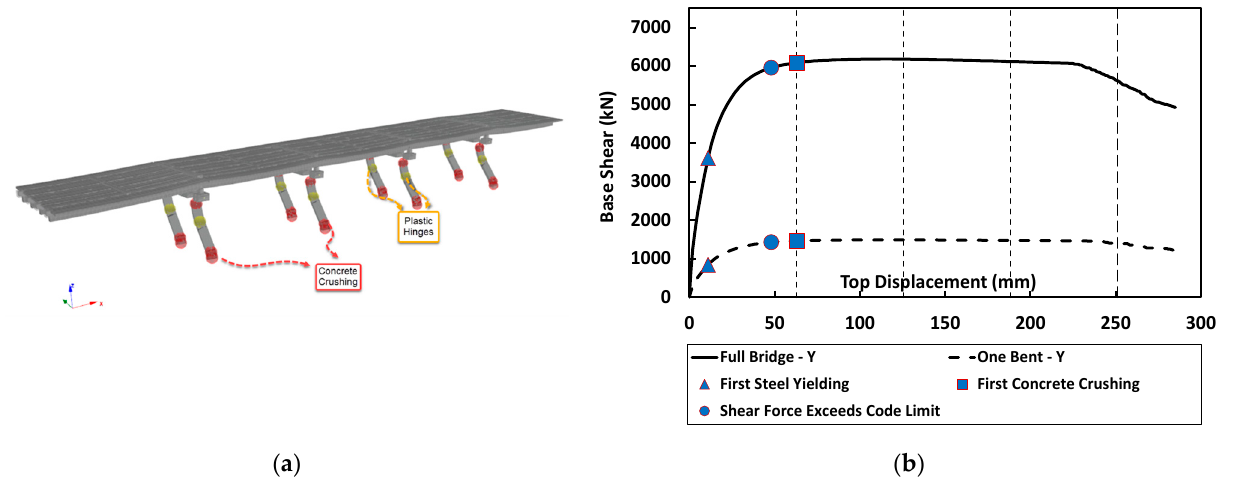
Figure 13. Pushover analysis results in the transverse (Y) direction: ( a ) deformed shape and damage locations, and ( b ) capacity curves of the one bent and the whole bridge.